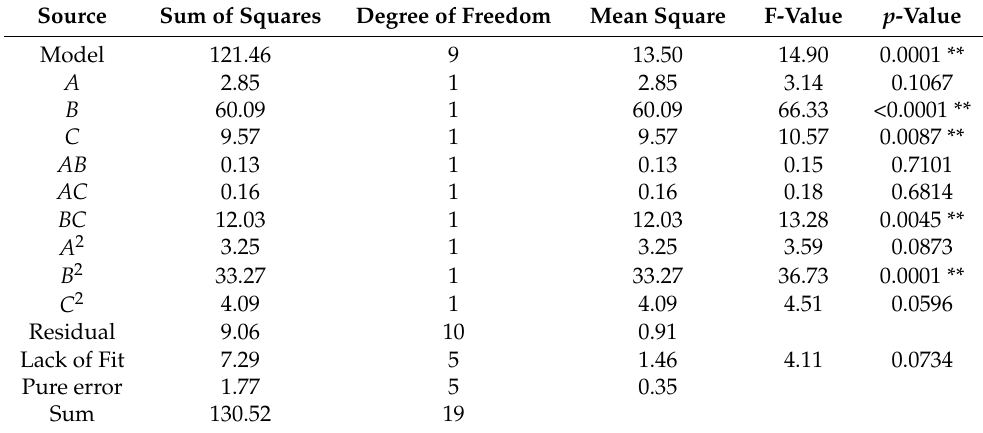
Table 14. Analysis of